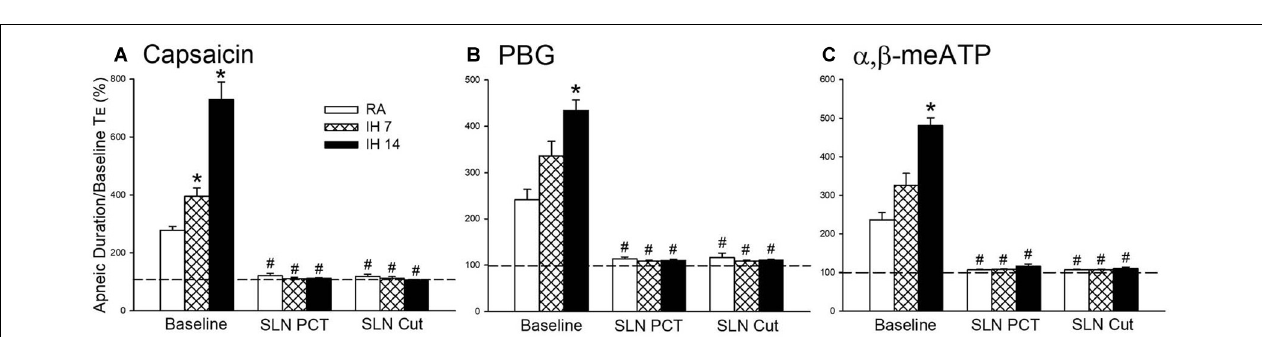
FIGURE 1 | Immediate responses to laryngeal challenges of capsaicin, phenylbiguanide (PBG), and α , β -methylene-ATP ( α , β -meATP) in three rats exposed to room air (RA) (A) , intermittent hypoxia for 7 days (IH7; B ) or 14 days (IH14; C ). Local application of capsaicin (0.08 µ M), PBG (4.5 µ M), and α , β -meATP (0.05 µ M) (30 µ L volume) were performed by careful installation of the chemical stimulants into the laryngeal segment via a spinal needle (indicated by an arrow). The elapsed time between the two challenges was 20 min. ˙V R , respiratory flow; V T , tidal volume; ABP, arterial blood pressure.